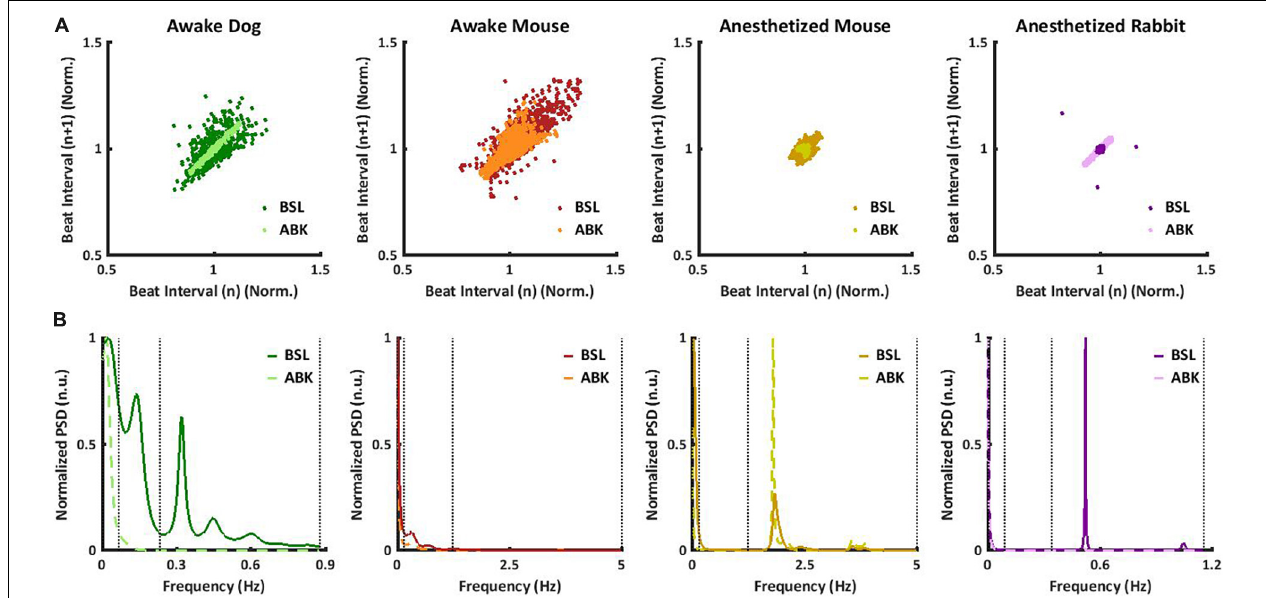
FIGURE 1 | Mammalian heartbeat intervals in the basal (BSL) and autonomic nervous blockade (ABK) states. Representative examples, for each considered animal model, of (A) normalized Poincaré plot and (B) normalized power spectral density (PSD) before and after ABK. All the results of the graphs are from the same window (BSL and